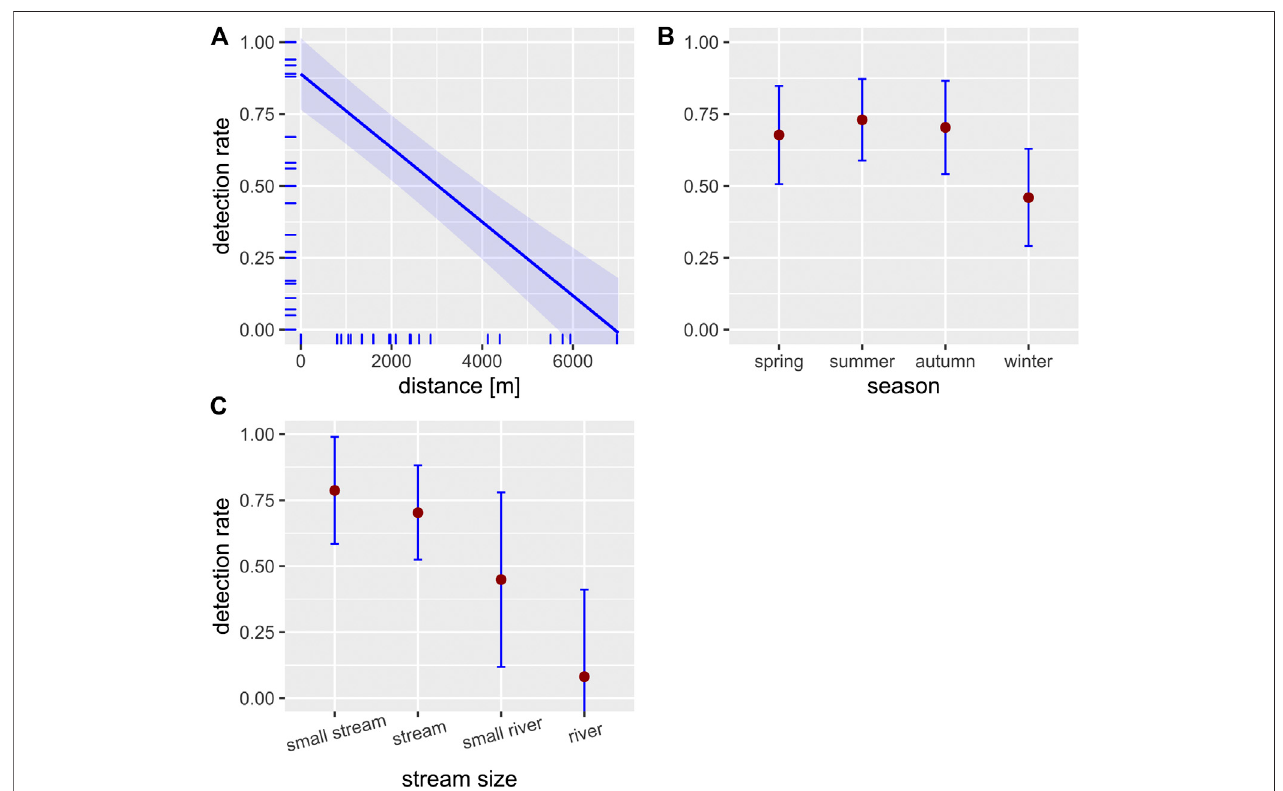
FIGURE 2 | Effectplots ofthe LMM used to predict the effect of the three independent variables distance (A) , season (B) and stream size (C) on the detection rate (proportionofpositivePCRs;blue-shadedareasanderrorbarsrepresentthe95%con fi denceintervals; N (cid:1) 40, see Table5 formodelstatistics).Smallticksontheaxes indicate the marginal distribution of the data.